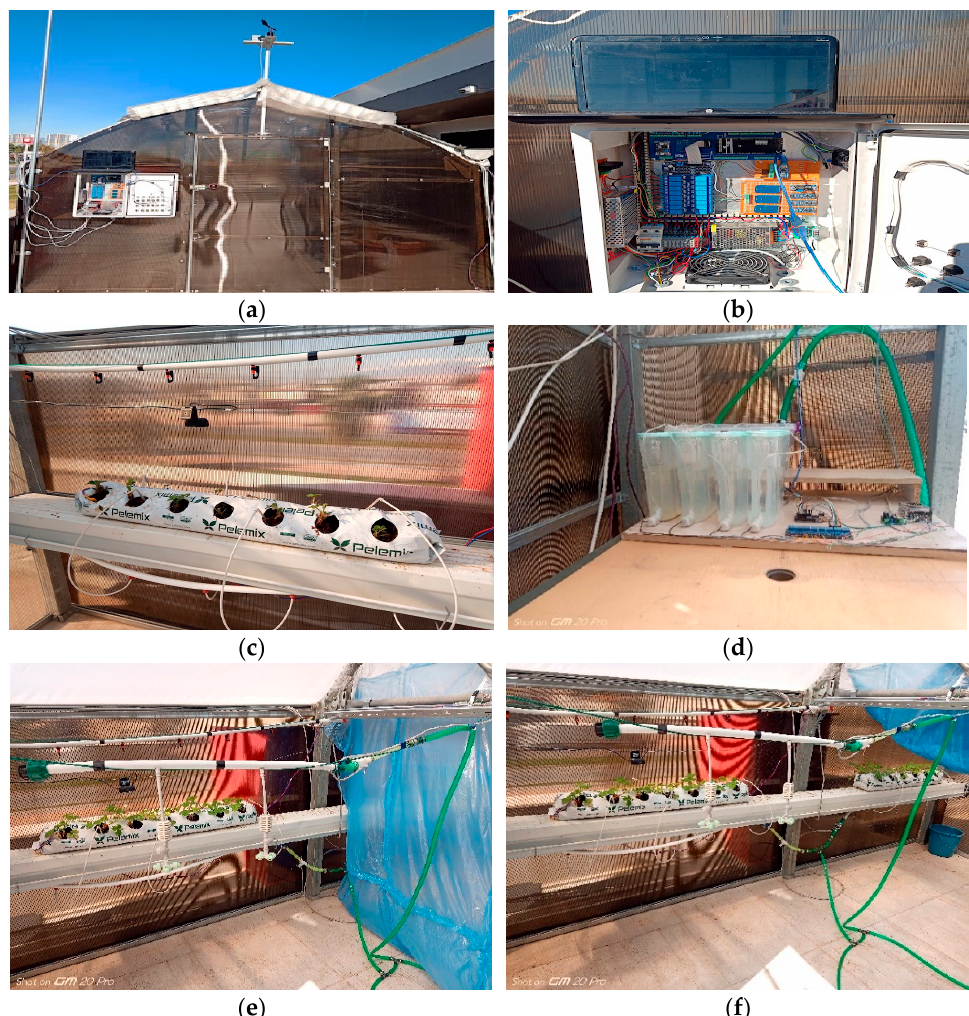
Figure 10. ( a ) Exterior view of the application greenhouse. ( b ) Internal view of the control board. ( c ) View of the strawberry plants, including irrigation system, webcam, and spraying sprinklers. ( d ) Four different spraying tanks, mixing tank, and control system. ( e ) General view of the application system with the humidification system included. ( f ) System controlled by deep learning and normal system view.